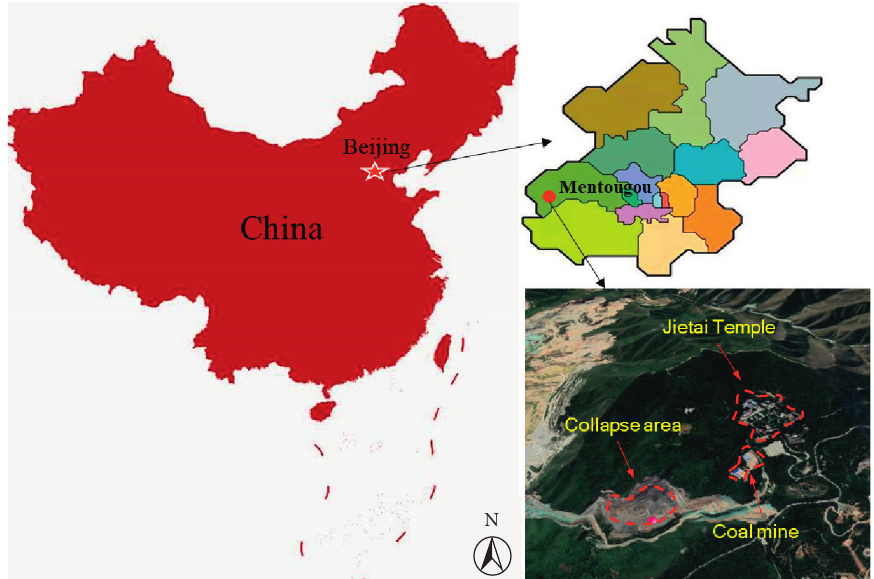
Figure 1: Location of the Jietai Temple